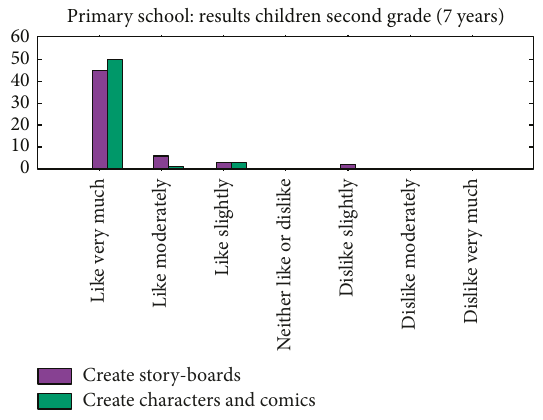
Figure 10: Results of the satisfaction survey for the second in- tervention in the second grade for children aged 7 years (primary